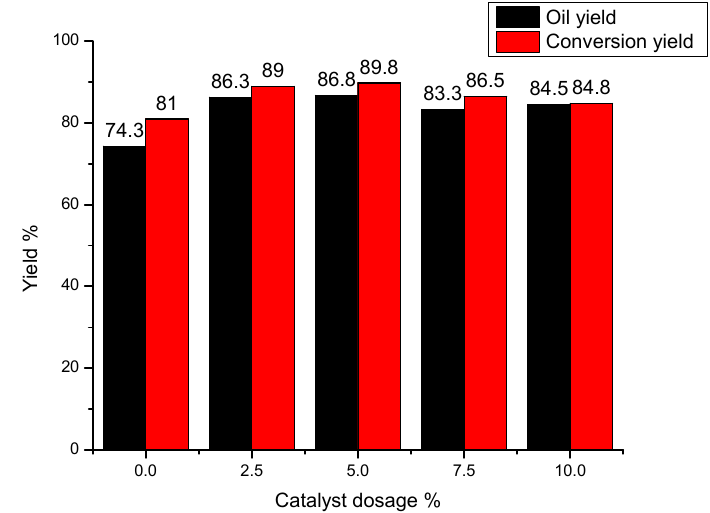
Figure 4. E ff ect of catalyst amount on lignin conversion. Reaction conditions: reaction